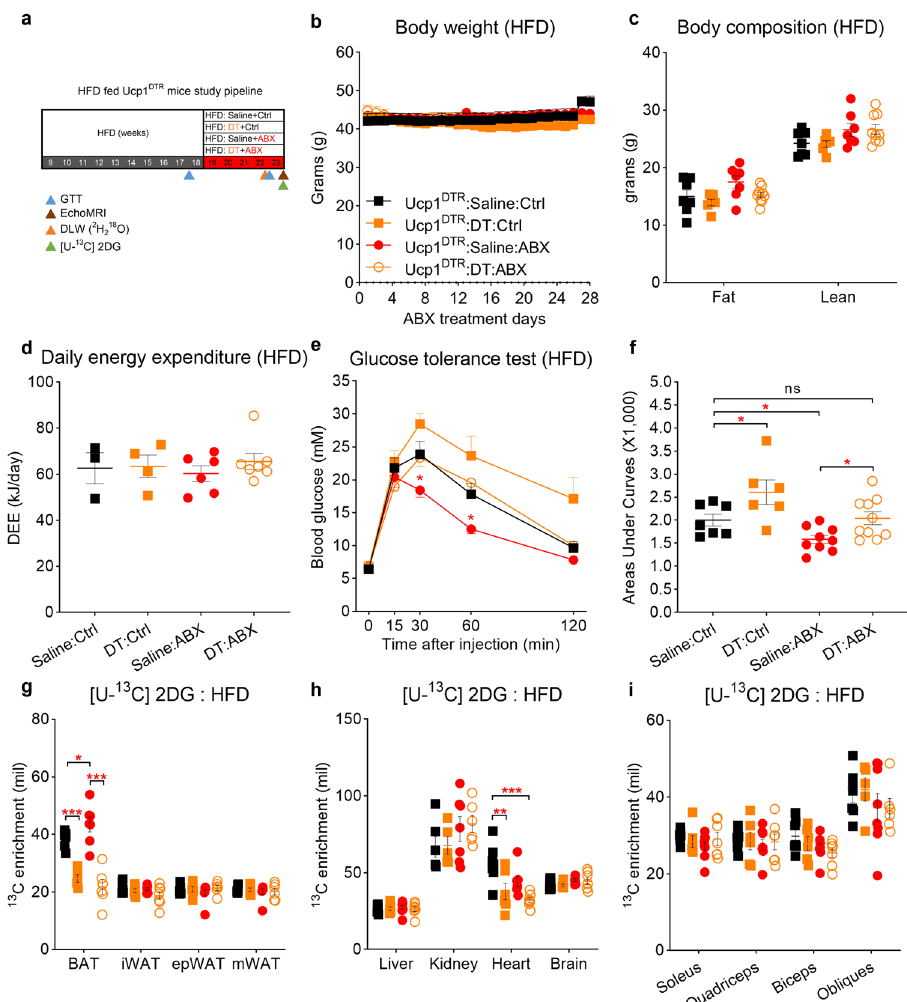
Fig. 5 Ucp1 + cells are indispensable for gut microbiota depletion-induced glucose improvement in obese mice. a Experimental scheme. 10-weeks